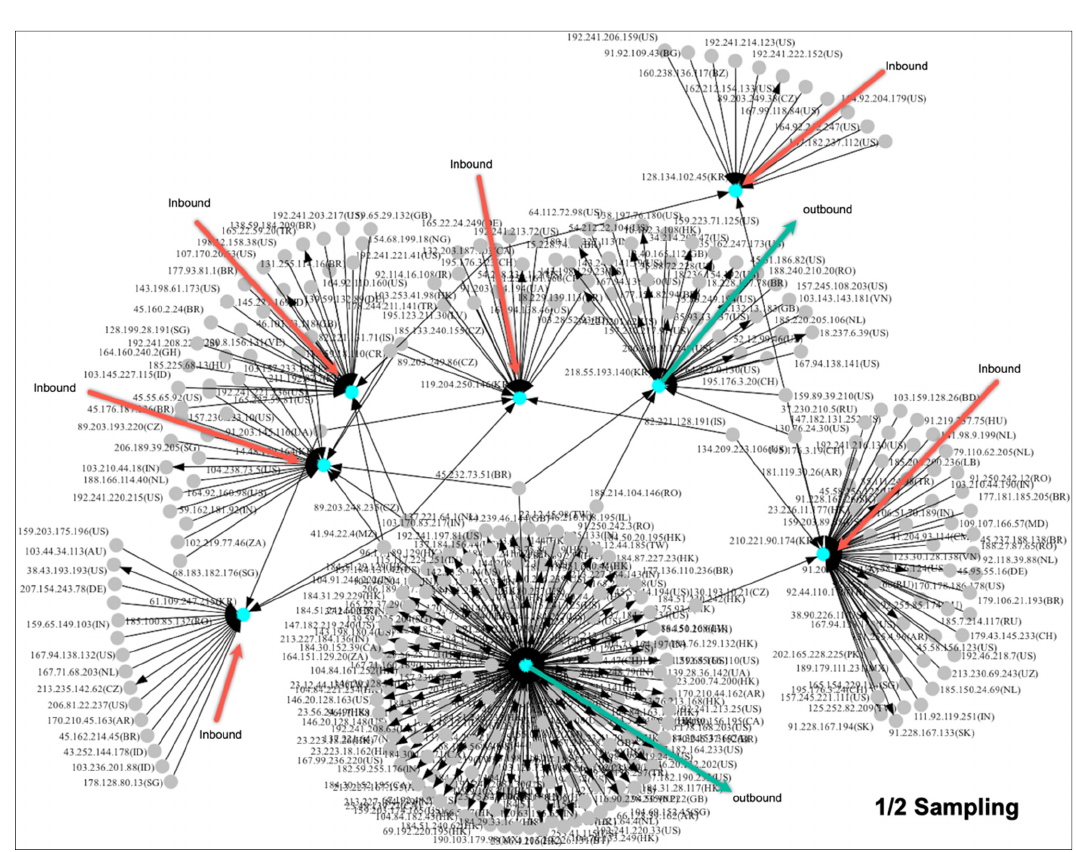
Figure 13. Sampling the structure of communication traffic generated in the affected area.